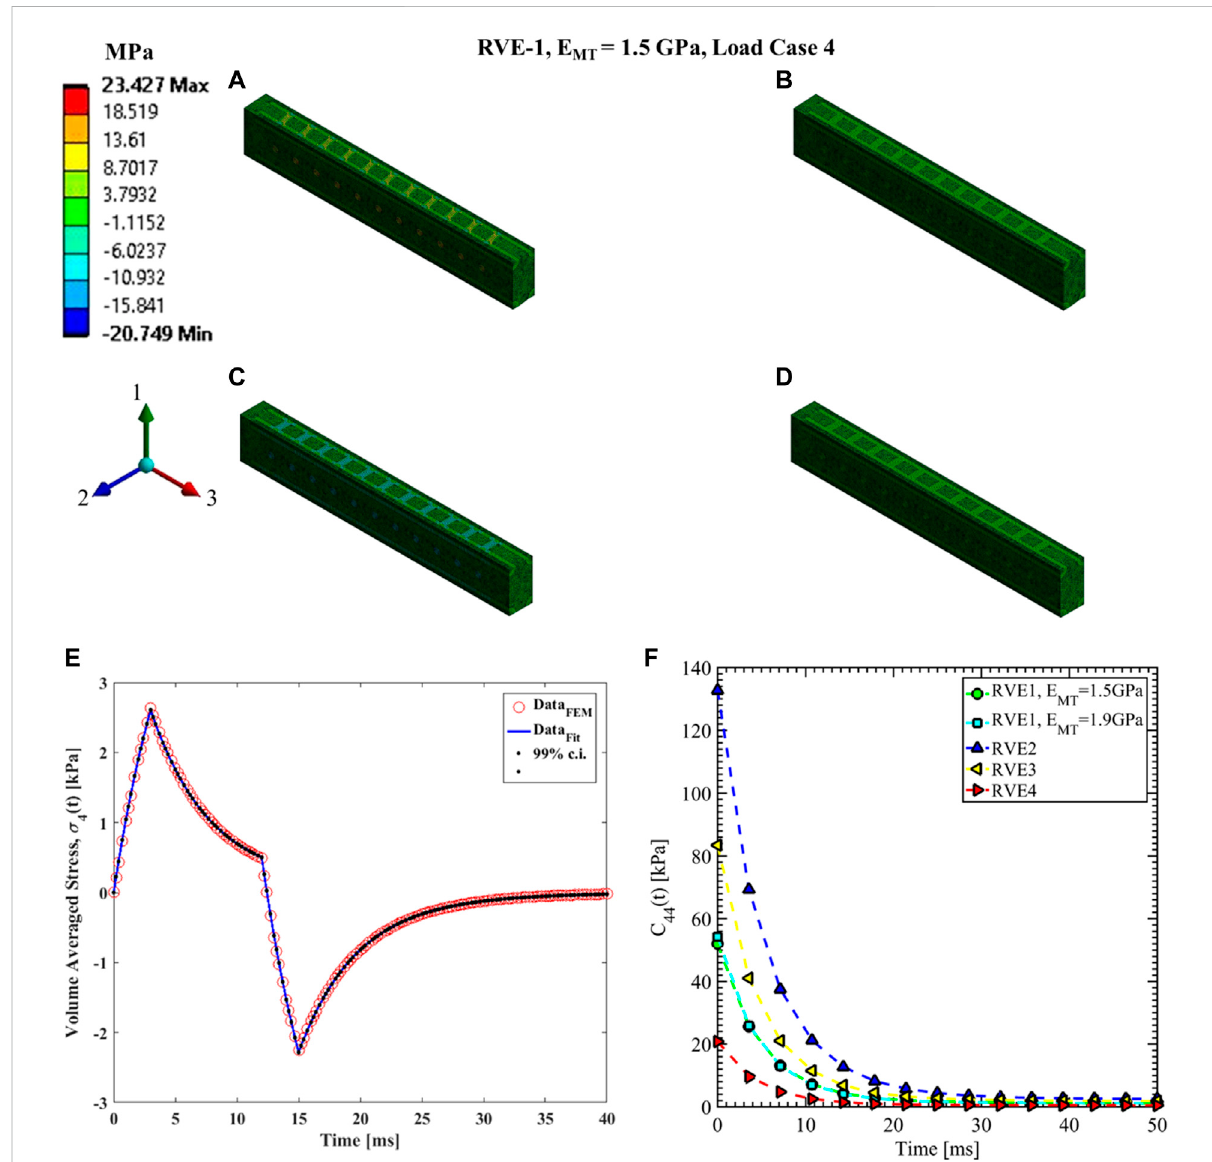
FIGURE 12 Contour plot of the element shear stress in directions 2 and 3 ( [ σ 4 ( t )] ρ from Eq. 16). C 44 ( t ) estimation for the RVE-1 with E MT (cid:2) 1 . 5 GPa by imposing the load case 4. (A) t 1 (cid:2) 3 ms , δ 4 ( t 1 ) (cid:2) 3 nm (B) t 2 (cid:2) 12 ms , δ 4 ( t 2 ) (cid:2) 3 nm (C) t 3 (cid:2) 15 ms , δ 4 ( t 3 ) (cid:2) 0 nm (D) t 4 (cid:2) 40 ms , δ 4 ( t 4 ) (cid:2) 0 nm .